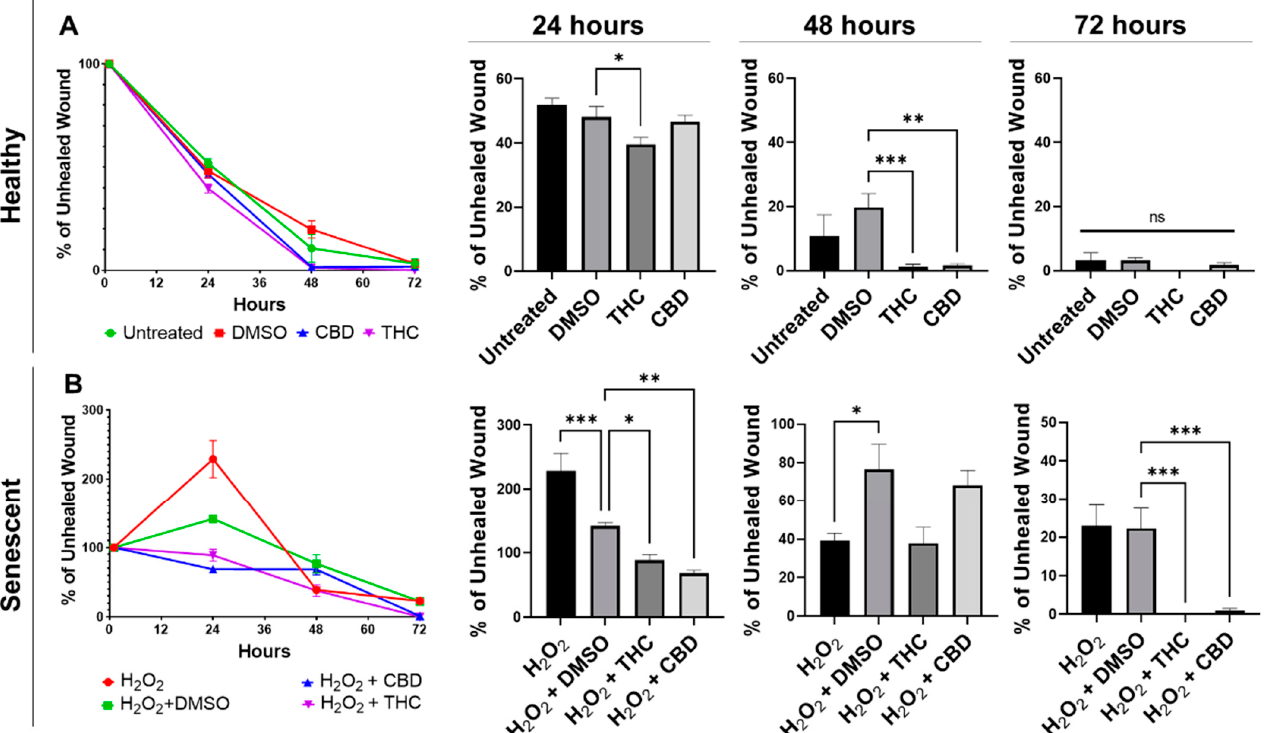
Figure 4. Phytocannabinoids improve wound healing in healthy and SIPS CCD-1064Sk (PDL 24) human dermal fibroblasts. ( A ) Percentage of the unhealed wounds at 24, 48, and 72 h after the scratch assay was performed with healthy dermal fibroblasts exposed to 2 µM of THC or CBD. ( B ) Percentage of the unhealed wounds at 24, 48, and 72 h after the scratch assay was performed with SIPS dermal fibroblasts exposed to 2 µM of THC or CBD. Data were analyzed with an ANOVA test followed by a Dunnett’s post-hoc multiple comparison test compared to the vehicle. Bars represent mean ± SEM, n = 6. Significance is indicated using the following scale: * p < 0.05, ** p < 0.01, *** p < 0.001. CBD, cannabidiol; DMSO, dimethyl sulfoxide (vehicle); SIPS, stress-induced premature senescence; THC, delta-9-tetrahydrocannabinol.